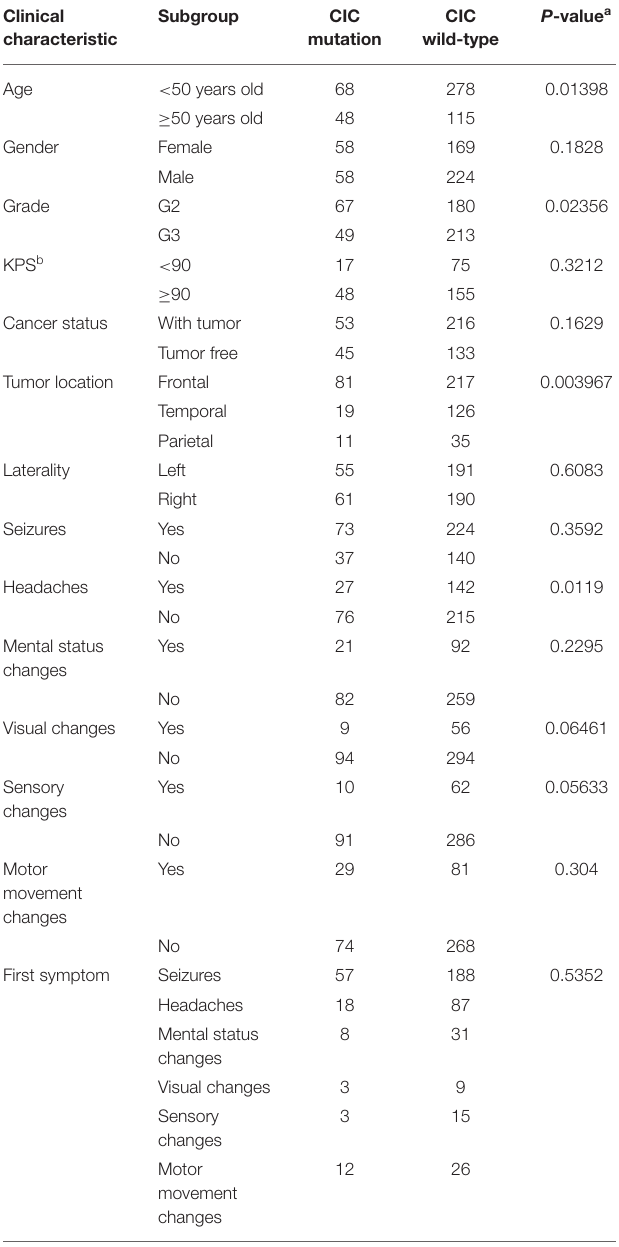
TABLE 1 | Associations between CIC mutation presence and clinical characteristics. Clinical